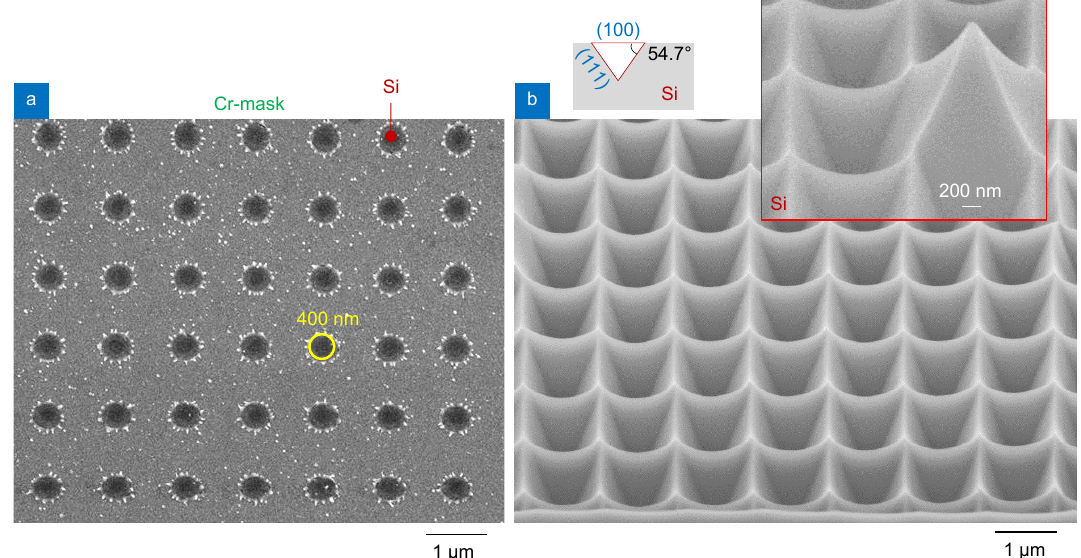
Fig. 3 | SEM images of a hard mask for RIE made in 50-nm-thick Cr film by laser ablation with 515 nm wavelength, 230 fs single laser pulses. Etched pattern after Cr mask removal. The inset shows an under-etch in the region where one ablation opening in the mask was absent. Conditions: NA = 0.9 lens was used, write speed 10 cm/s, pulse energy 5 nJ, laser repetition rate 200